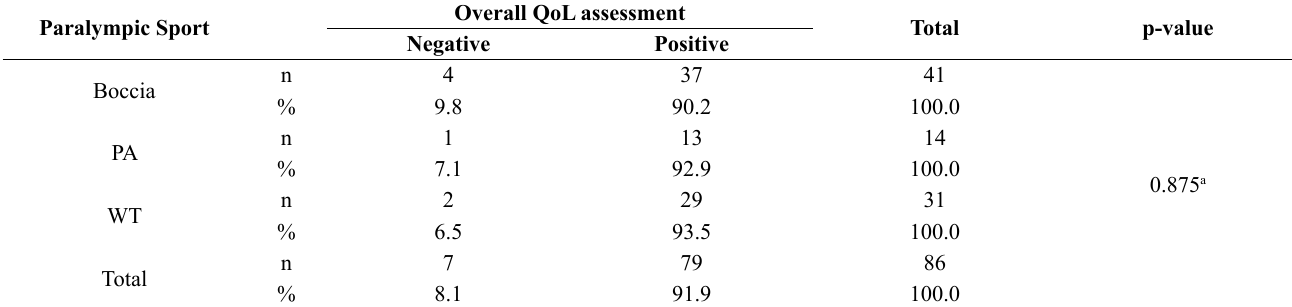
Table 2. Overall QoL assessment among Paralympic Sport athletes.